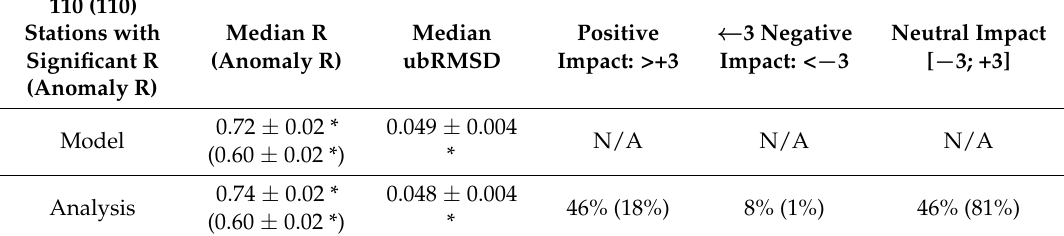
Table 3. Analysis impact evaluation against in situ measurements of soil moisture from the US Climate Reference Network (USCRN) network. In situ measurements at a depth of 5 cm are used to evaluate soil moisture from the third layer of soil (4–10 cm) from either the model or analysis experiment over 2010–2016. The normalized information contribution (NIC) is applied to the correlation (anomaly correlations) values. NIC scores are classified according to three categories: (i) negative impact from the analysis with respect to the model with values smaller than − 3%, (ii) positive impact from the analysis with respect to the model with values greater than +3%, and (iii) neutral impact from the analysis with respect to the model with values between − 3% and 3%.